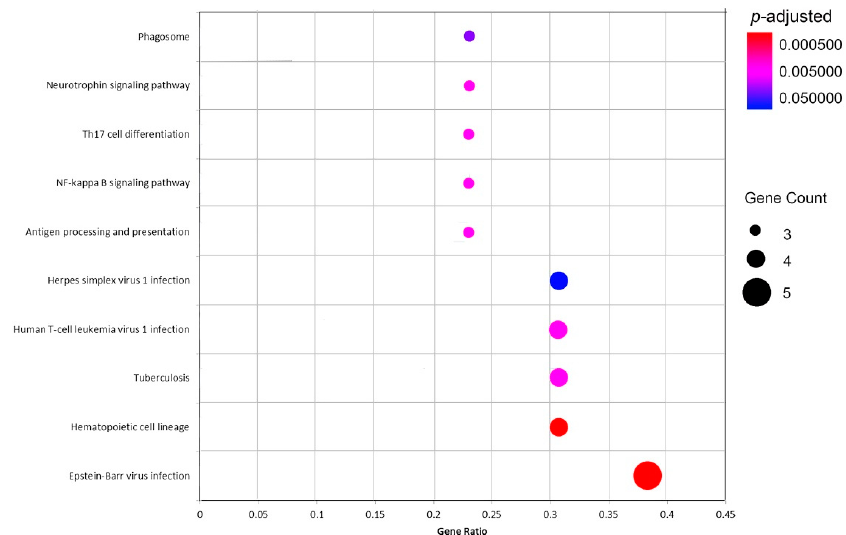
Figure 5. KEGG enrichment analysis of the common 14 up-regulated differentially expressed genes (DEGs) in both pterygium and primary Sjögren Syndrome (pSS) samples. Gene Ratio = The number